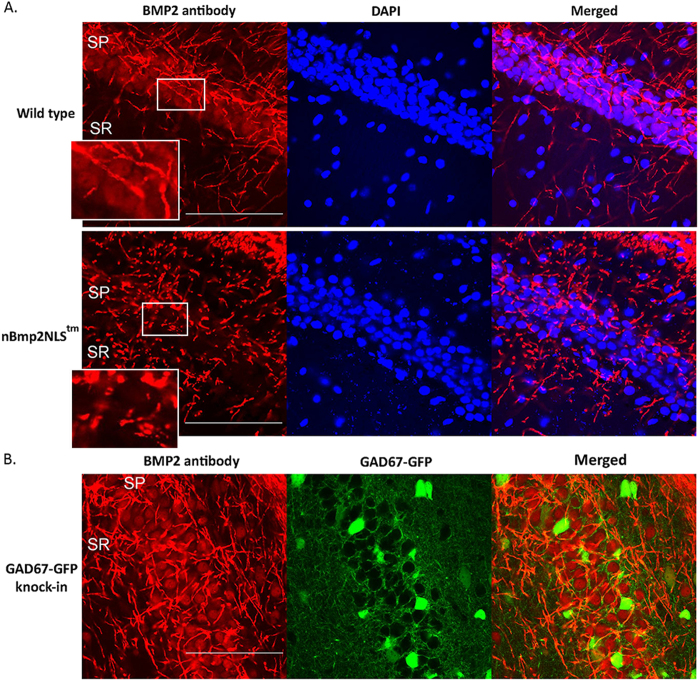
nBMP2 is expressed in the nuclei of wild type but not mutant CA1 region hippocampal neurons.(A) Brain sections from wild type and nBmp2NLStm mice were stained with fluorescently tagged anti-BMP2 antibody (red) and nuclei were stained with DAPI (blue). The CA1 region of the hippocampus is shown. High magnification insets of the highlighted region illustrate red BMP2 labeling in the nuclei of pyramidal cell soma of the stratum pyramidale in wild type mice, which is absent in the nBmp2NLStm mice. BMP2 labeling of neuronal projections is present in both wild type and mutant mice, confirming that the targeted mutation selectively eliminated only the nuclear variant of the protein. (B) Brain sections from GAD67-GFP fusion knock-in mice were stained with fluorescently tagged anti-BMP2 antibody (red). All sections were imaged using laser confocal microscopy. Scale bars indicate 100 μm. SP: stratum pyramidale; SR: stratum radiatum.